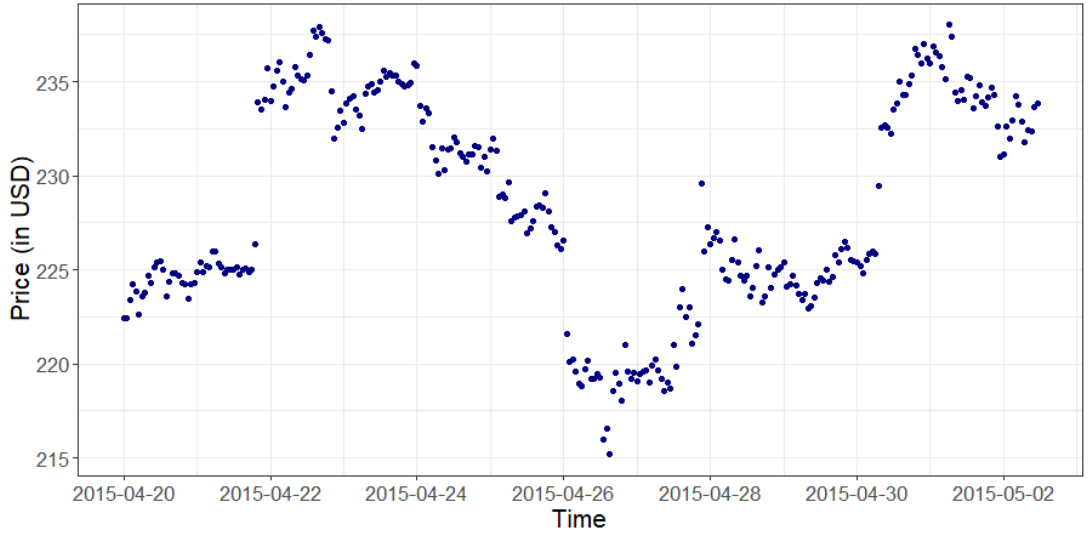
Fig. 8. Bitcoin hourly price (in US dollars) during a two-week period between late April and early May of